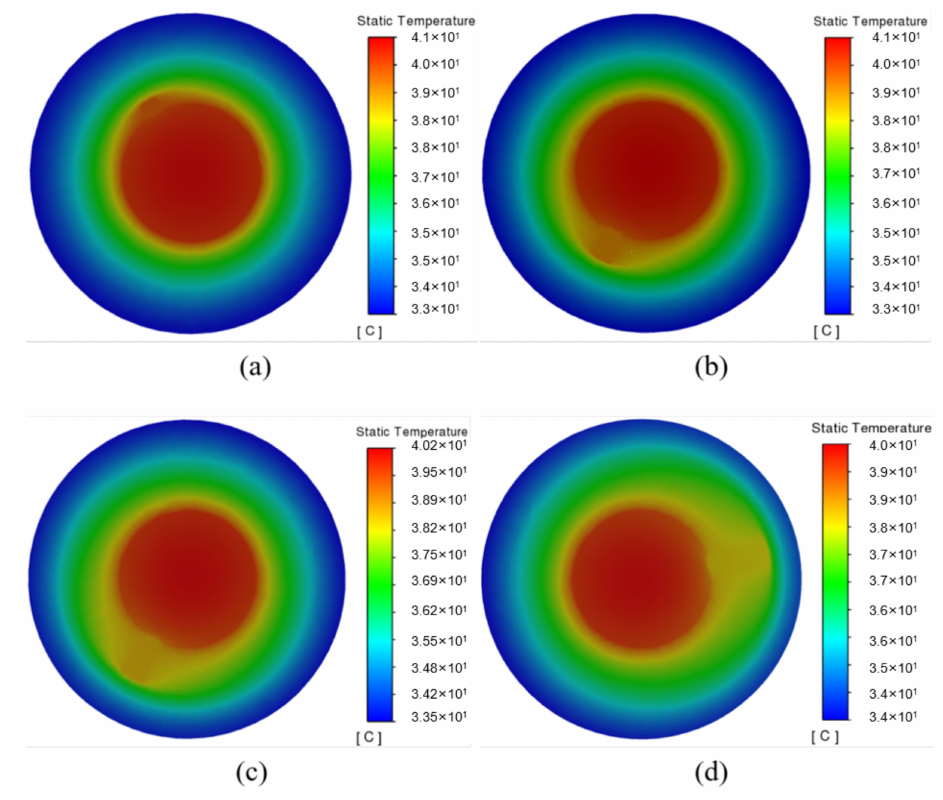
Figure 8. Temperature cloud diagram of cross section of battery with different fin widths: ( a ) 2 mm; ( b ) 4 mm; ( c ) 6 mm; ( d ) 8